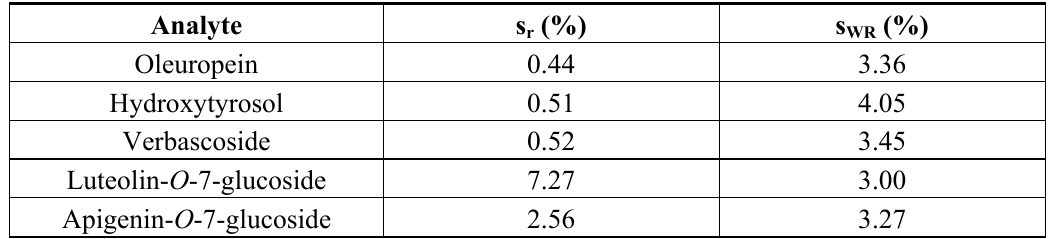
) and the within- r ) for each phenolic WR